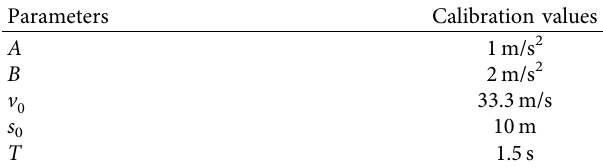
Table 3: Result of parameter calibration of IDM.